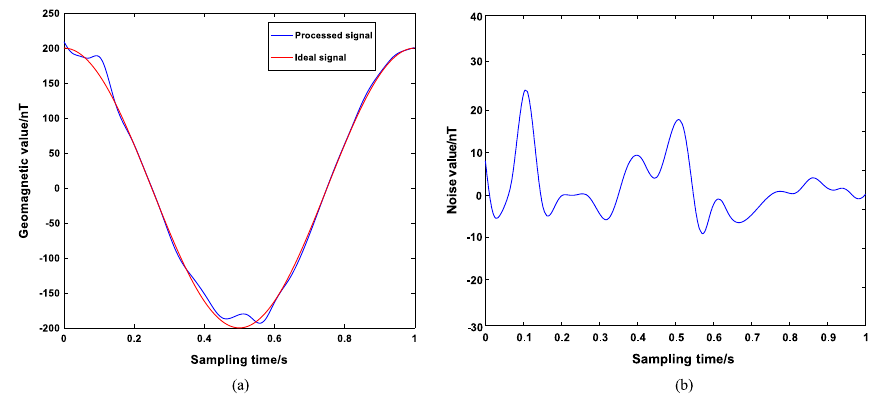
Fig. 12 Signal processing results of Zhou’s algorithm